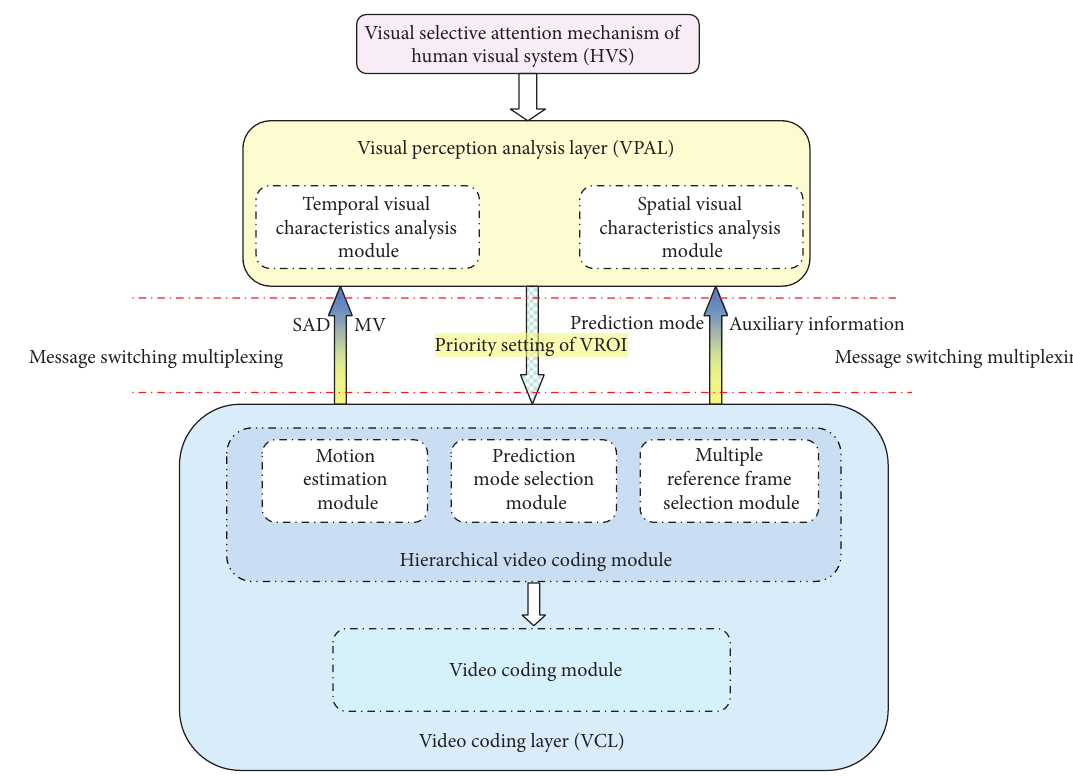
Figure 4: Video coding framework diagram.